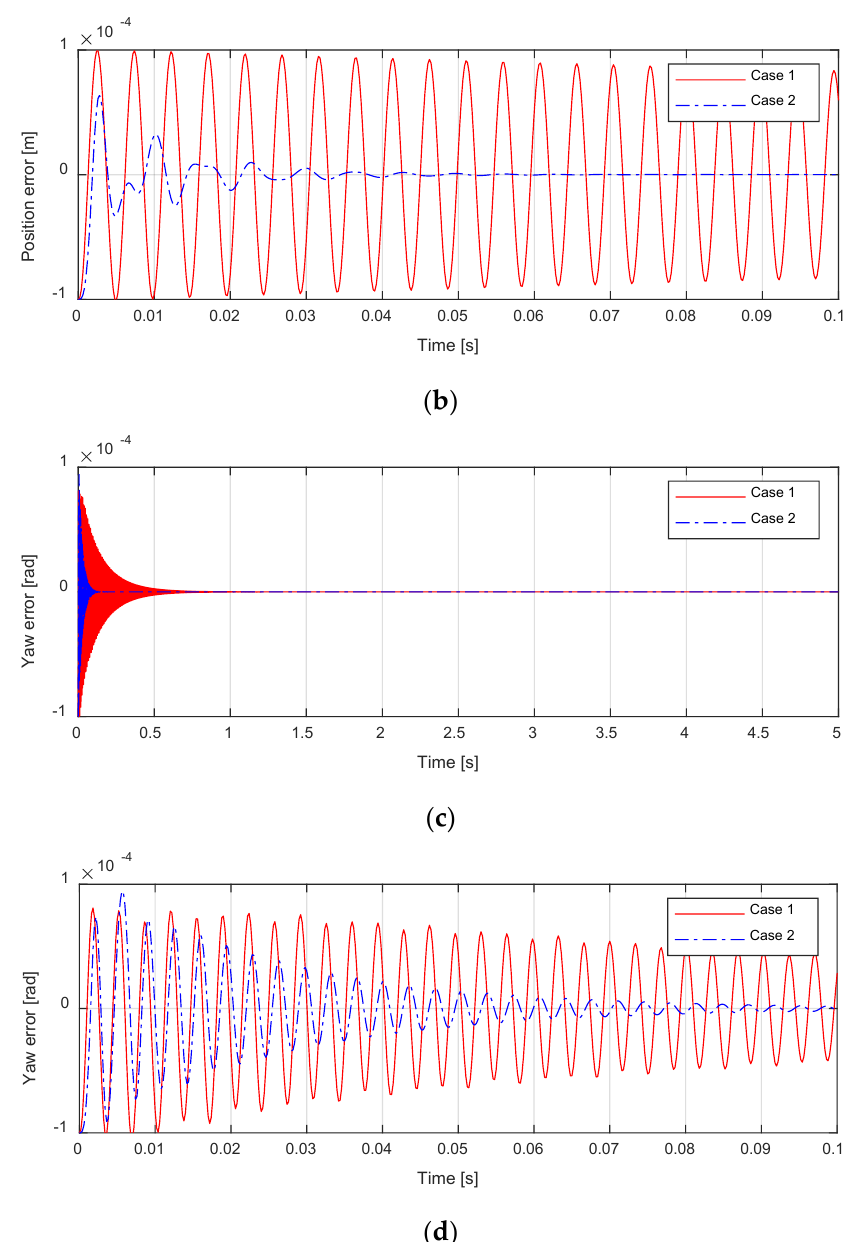
Figure 8. Position tracking performance of X − axis position and yaw with uncertain parameters. ( a ) X − axis position tracking performance. ( b ) X − axis position tracking performance (enlarged). ( c ) Yaw tracking performance. ( d ) Yaw tracking performance (enlarged).